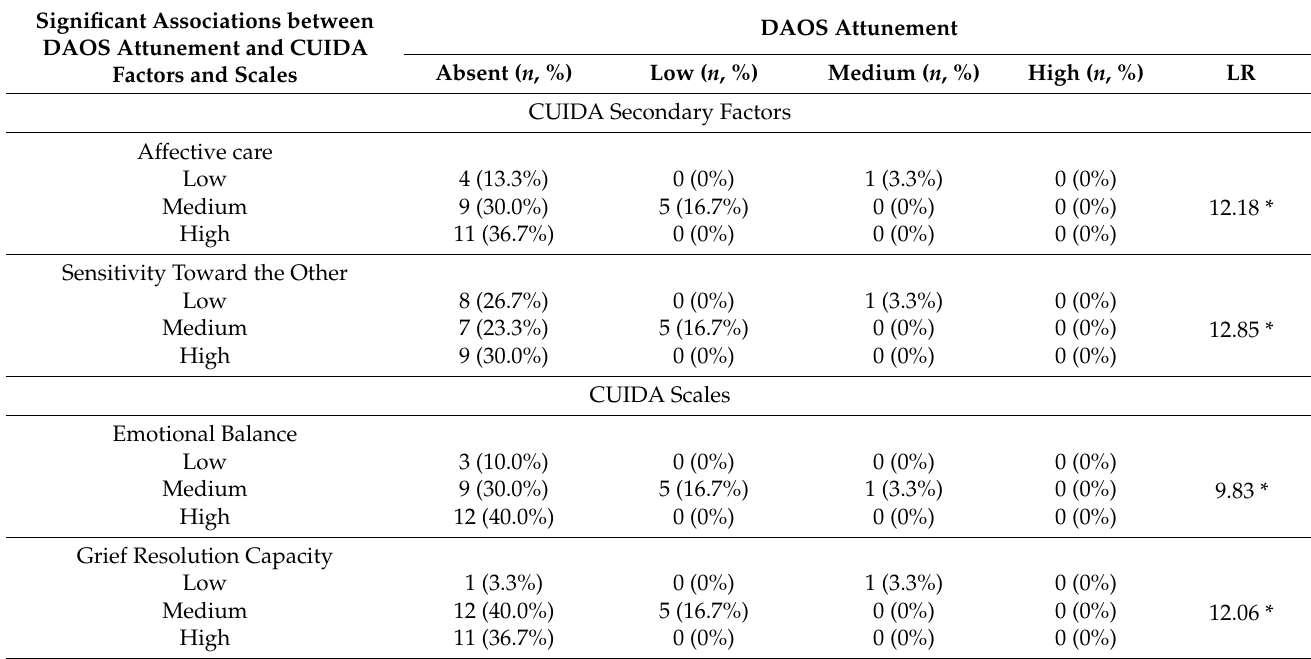
Table 5. Significant associations between DAOS attunement and CUIDA factors and scales. Significant Associations